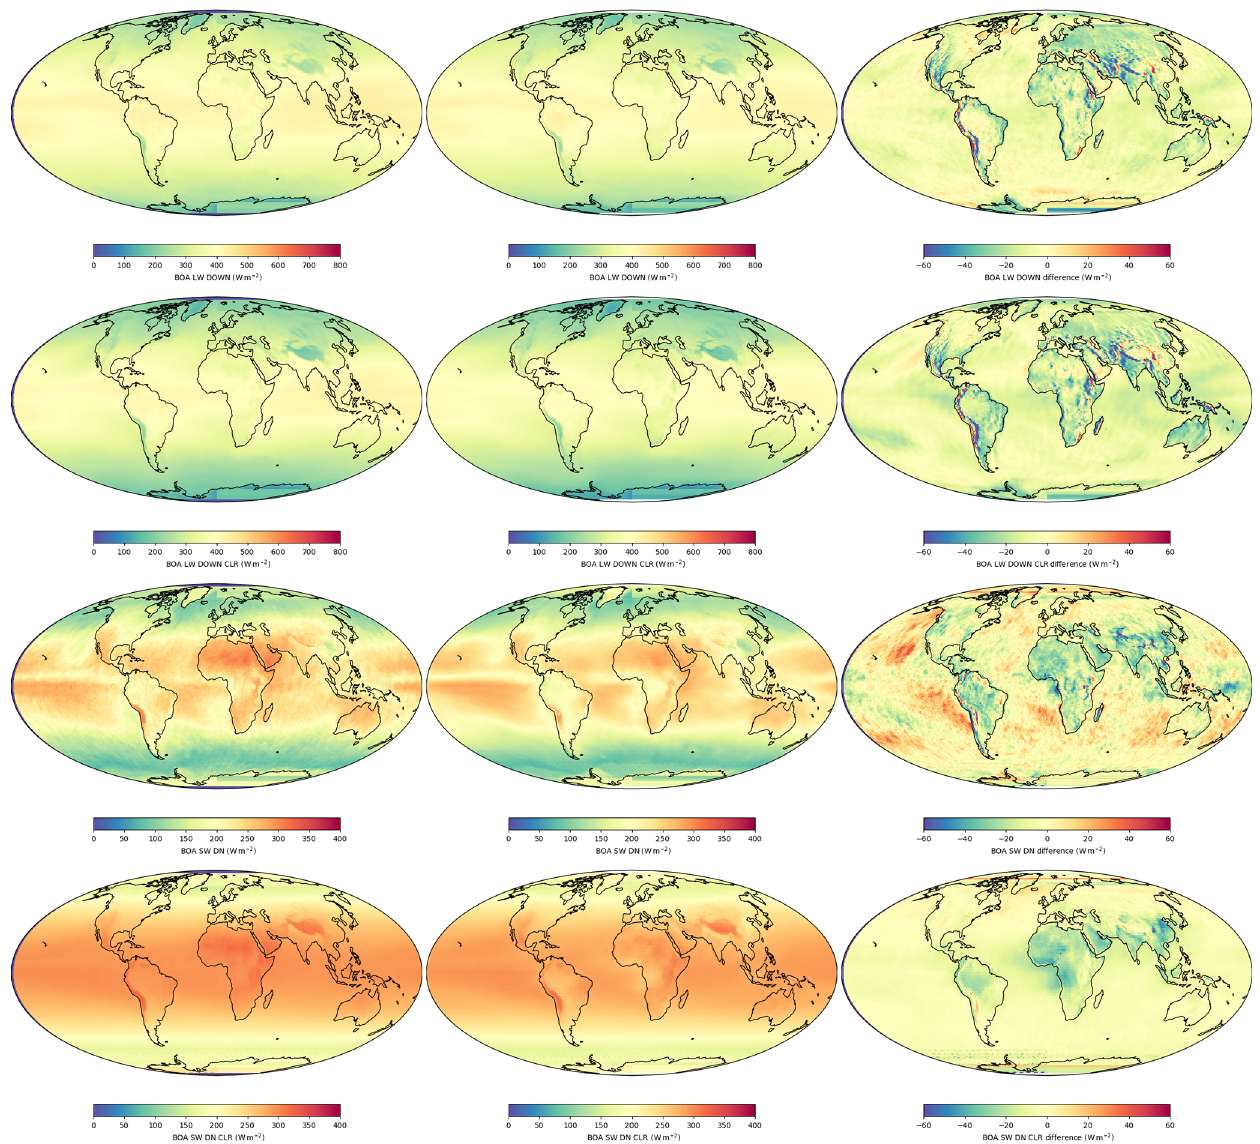
Figure 5. Examples of Level-3C (yearly average for 2008) Cloud_cci AATSR V3 (left column) and CERES (middle column) and the difference between CERES and AATSR (right column): global maps of forcing, from top to bottom, LWF down and SWF down BOA